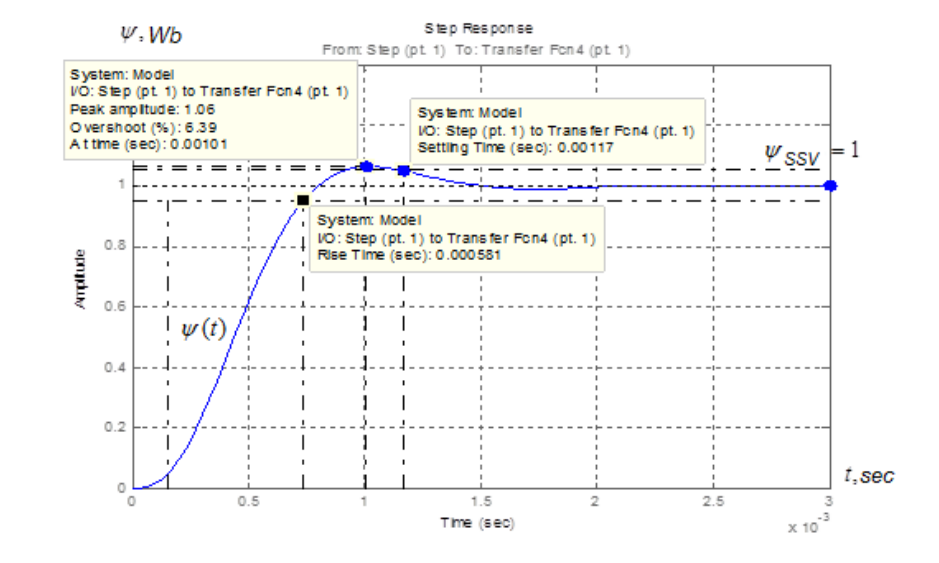
Figure 7. Flux-linkage loop transient characteristic